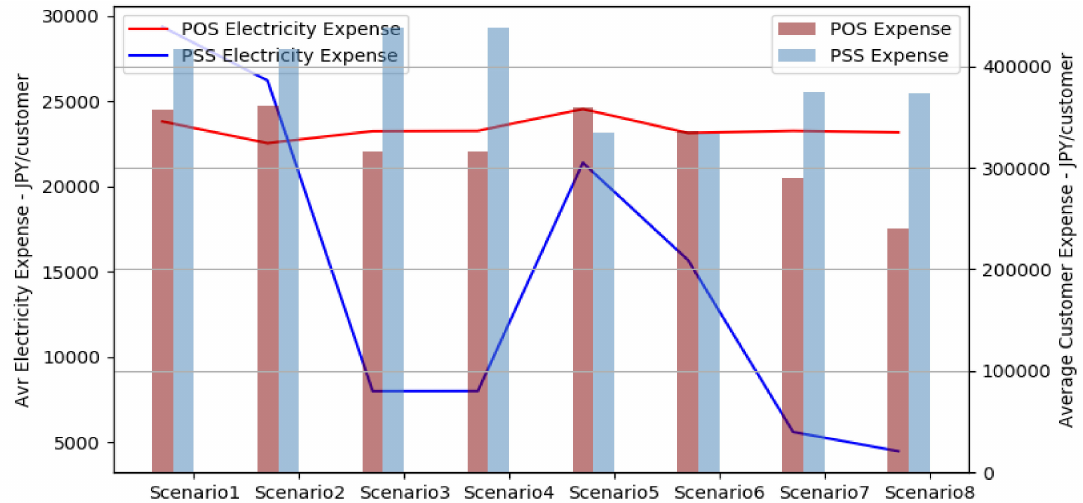
Figure 12. POS & EPSS Electricity Expense Comparison.